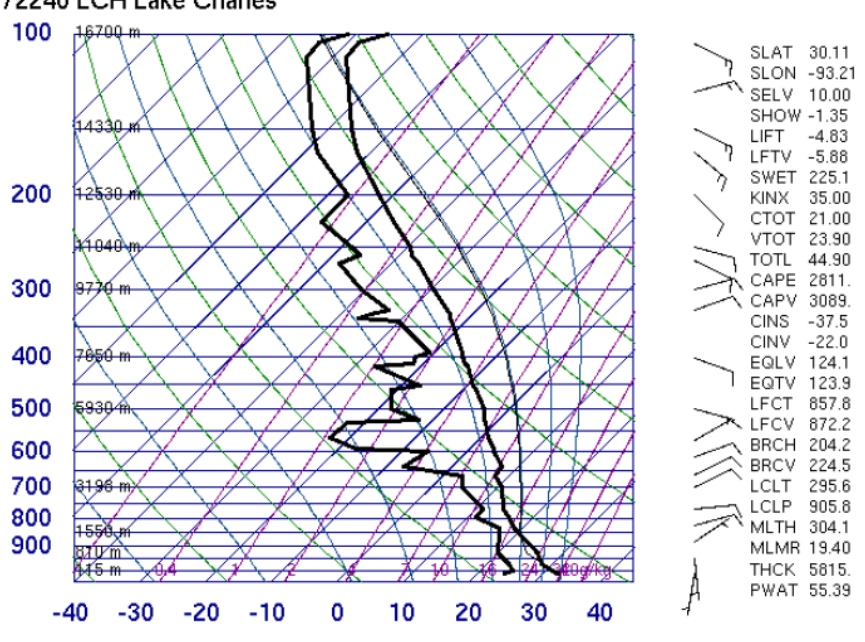
Figure 10. The atmospheric soundings over the Lake Charles station on 25 August